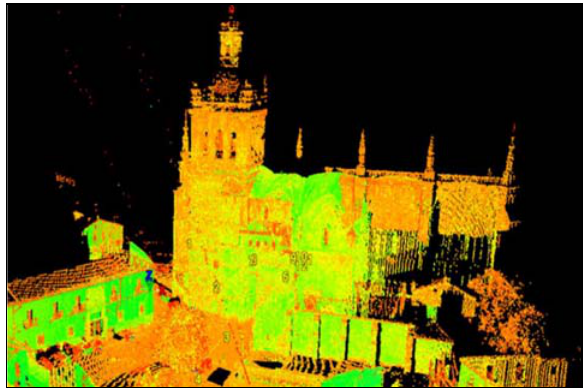
Figure 8. Cloud of points recorded with the Cyclone Navigator.